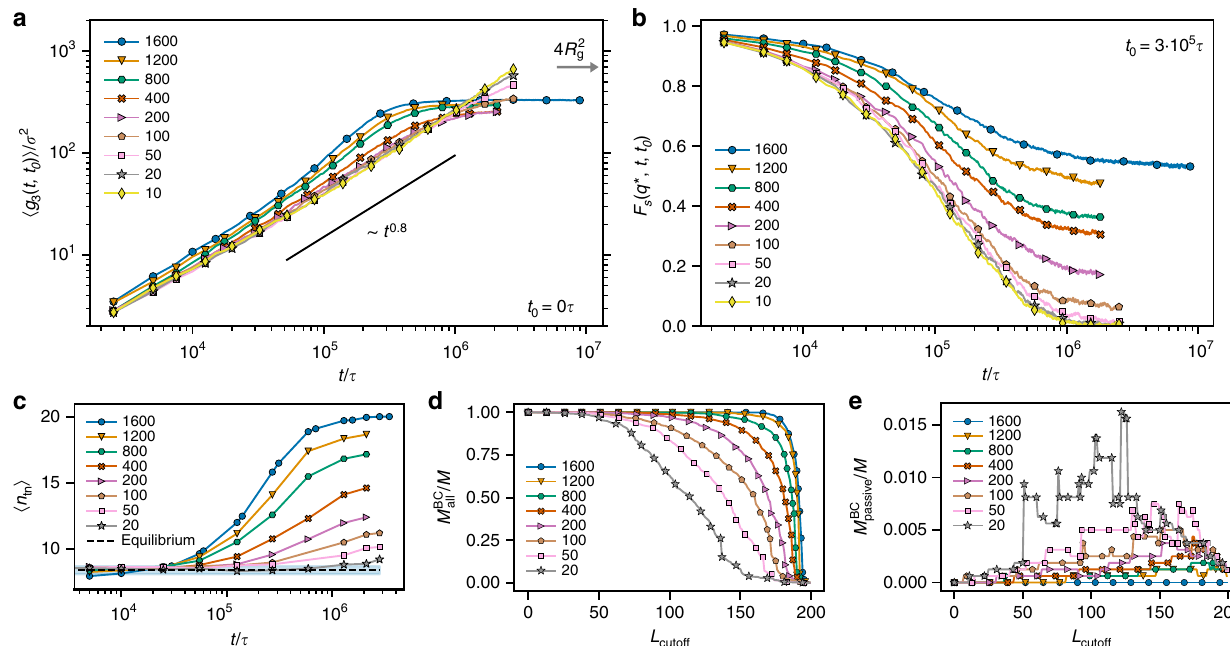
Fig. 8 Varying the number of active rings. a Mean squared displacement of the rings ’ centers of mass from the onset of the activity ( t 0 ¼ 0) as a function ð q (cid:5) ; t ; t Þ as a function of t evaluated of time for different numbers M of partly active rings indicated in the legend. b Self-intermediate scattering function F 0 a s i by a ring as a function of time from the activity onset for at q (cid:5) σ ¼ 0 : 35 and t 0 ¼ 3 ´ 10 5 τ for different M . c Mean number of threaded neighbors h n a tn different M (see also Supplementary Fig. 8). d , e Threading cluster analysis for systems at with different number of partly active rings at t ¼ 2 : 1 ´ 10 6 τ . a d Relative size of the biggest cluster of those clusters that contain any kind (active and passive) of rings. e Relative size of the biggest cluster of those clusters that contain only passive rings (see Methods for details). Note the difference in the scale of the ordinate for the passive ring